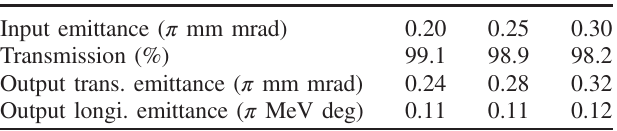
TABLE IV. Input-transverse-emittance dependence of the epRFQ simulation.